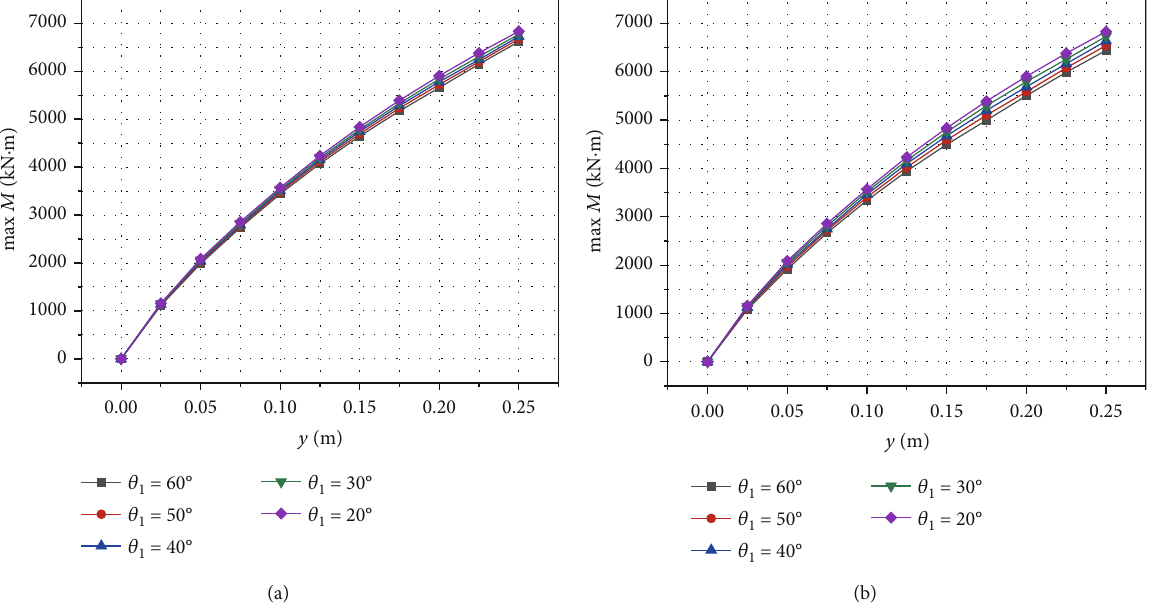
= 1 m. (b) Considering Z 1